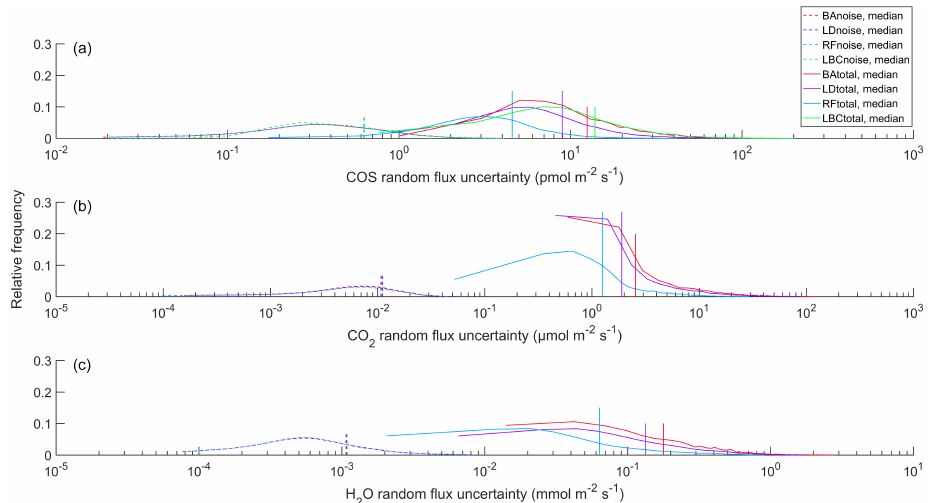
Figure 7. Frequency distribution of calculated total random uncertainties (solid lines) and instrument noise (dashed lines) for COS (a) , CO 2 (b) and H 2 O (c) and different high-pass filtering scenarios (block averaging – BA, linear detrending – LD, recursive filtering – RF, LBC – linear background correction). The vertical lines indicate the respective median values.